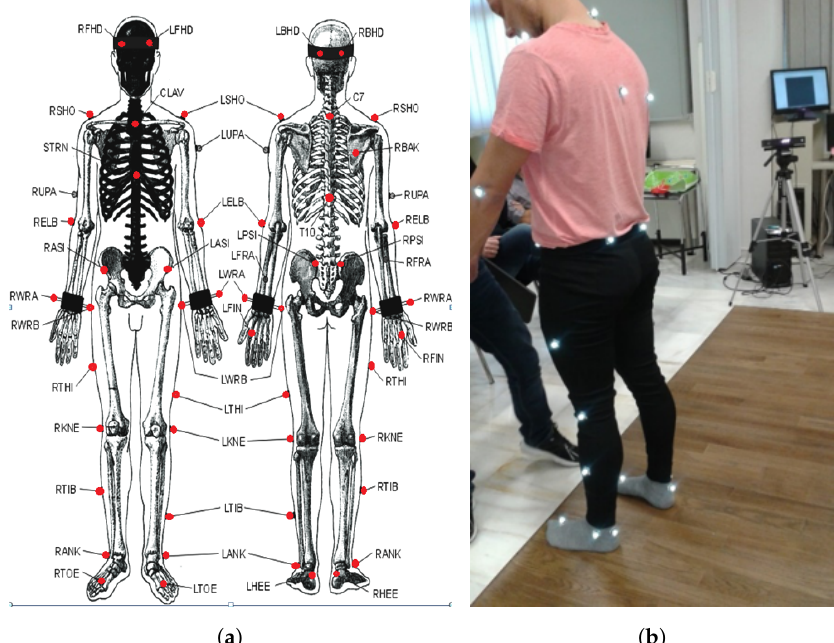
Figure 6. ( a ) VICON body joints capturing capabilities. ( b ) Placement of markers to the